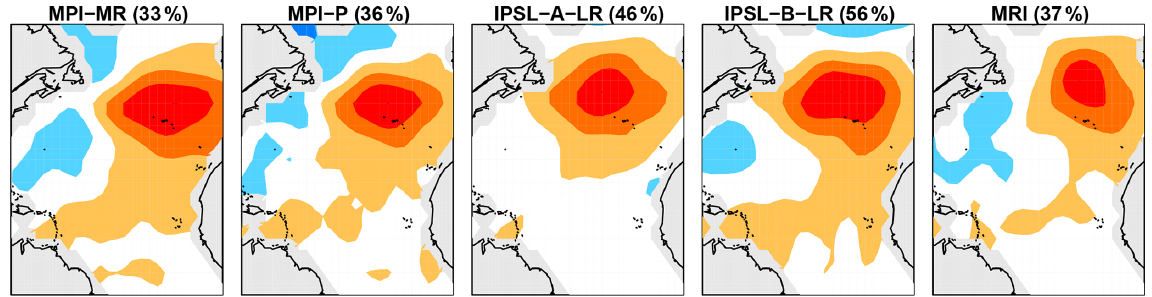
Figure 4. Regression patterns between local SST and the discriminant associated with the largest model-to-observation variance ratio. Only regression patterns associated with significant maximum variance ratios are shown. Each regression pattern is scaled to have a maximum absolute coefficient of one and is then plotted using the same color scale (red and blue are opposite signs). The CMIP5 model and percent of deviance D 1 : 2 explained by the discriminant are indicated in the title of each